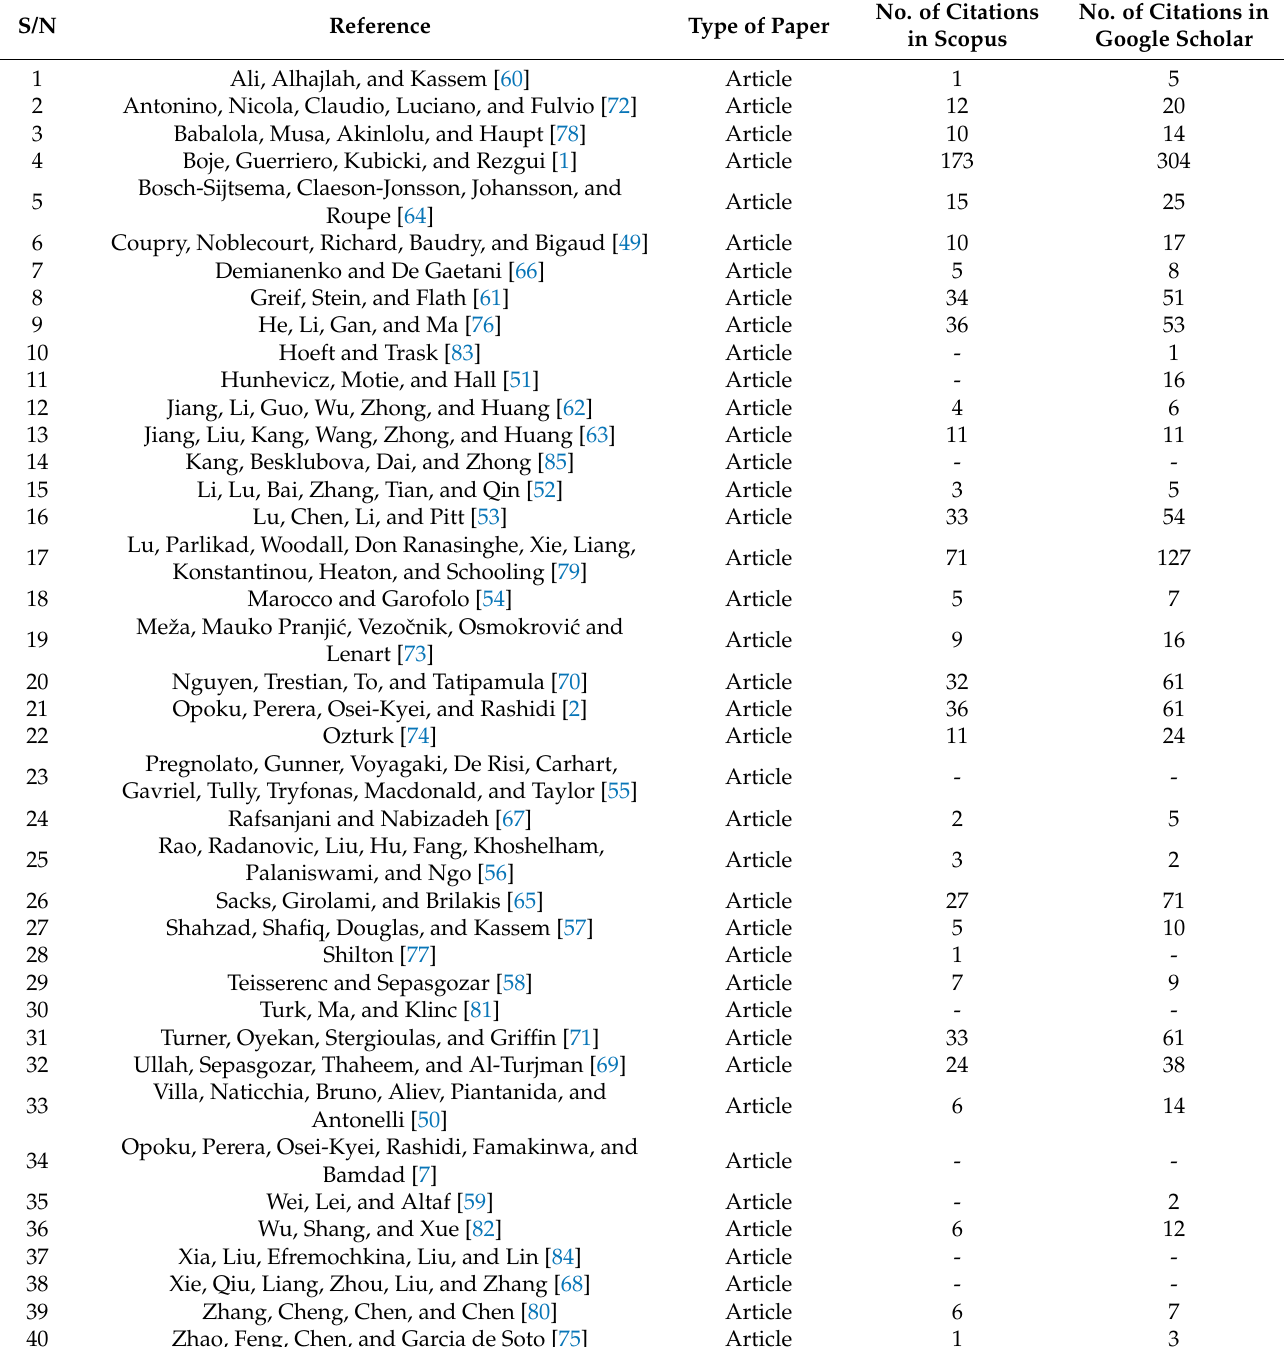
Table 3. Citation records of the papers identified for the